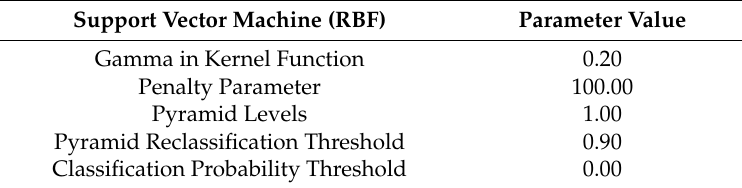
Table 3. Definition of the parameters used for SVM classification in ENVI@